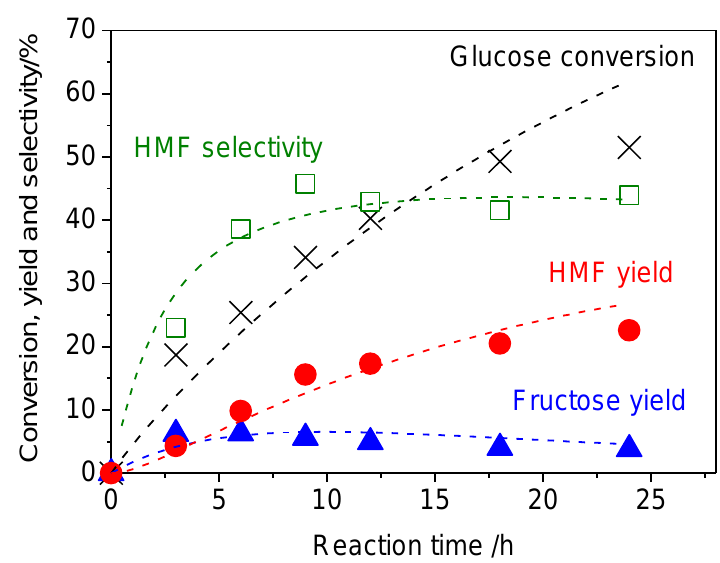
Figure 5. Time course of HMF formation from glucose over HNbWO 6 aggregated nanosheets. Reaction conditions : glucose (50 mg), catalyst (50 mg), water (3 mL), 393 K. The symbols represent the experimental results, and the curves are the calculated fits.